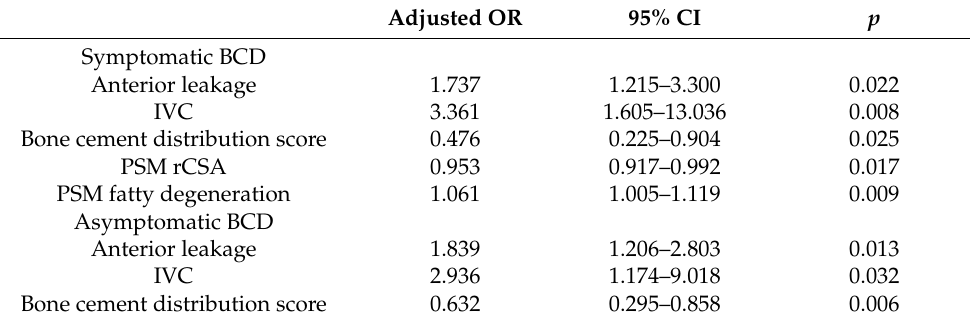
Table 4. Multiple logistic regression